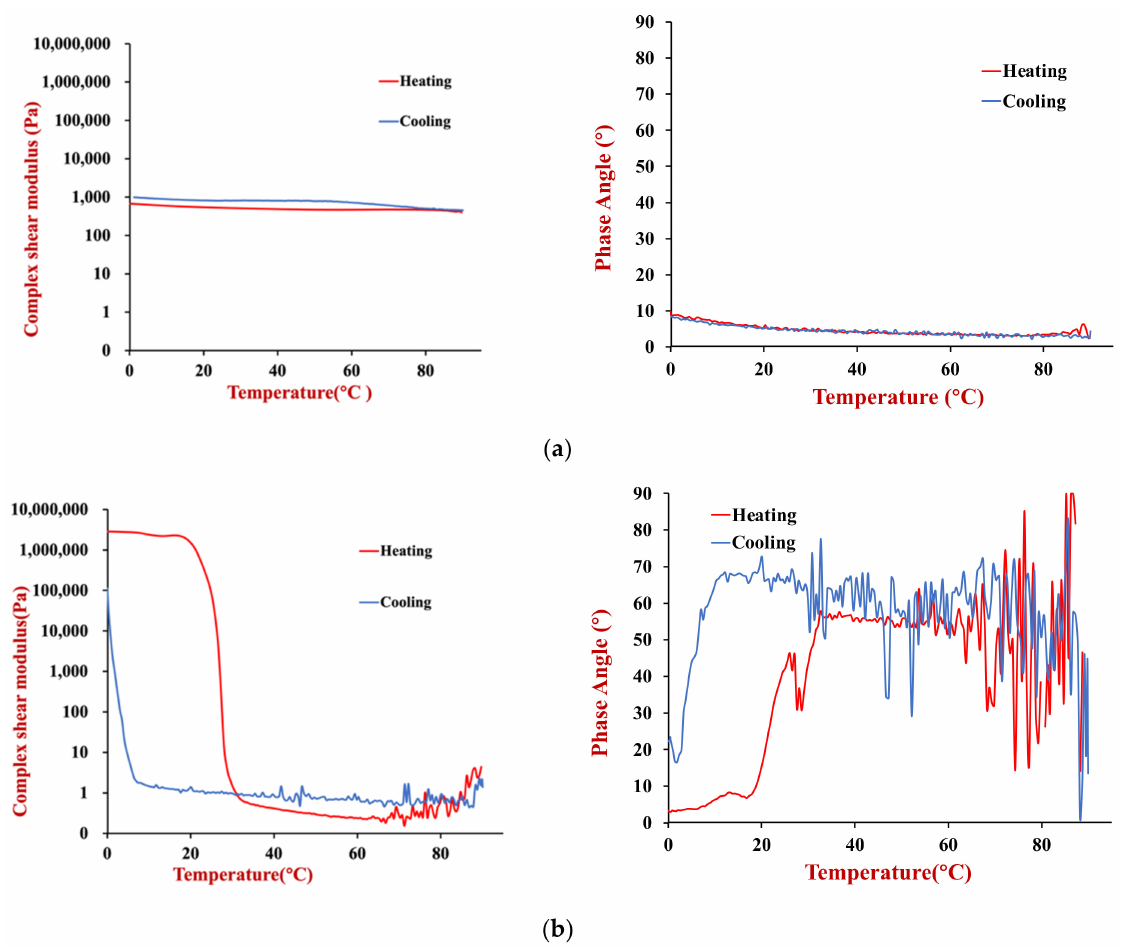
Figure 7. ( a ) Change in complex shear modulus and phase angle with temperature of soybean oil HIPEs during heating and cooling. ( b ) Change in complex shear modulus and phase angle with temperature of coconut oil HIPEs during heating and